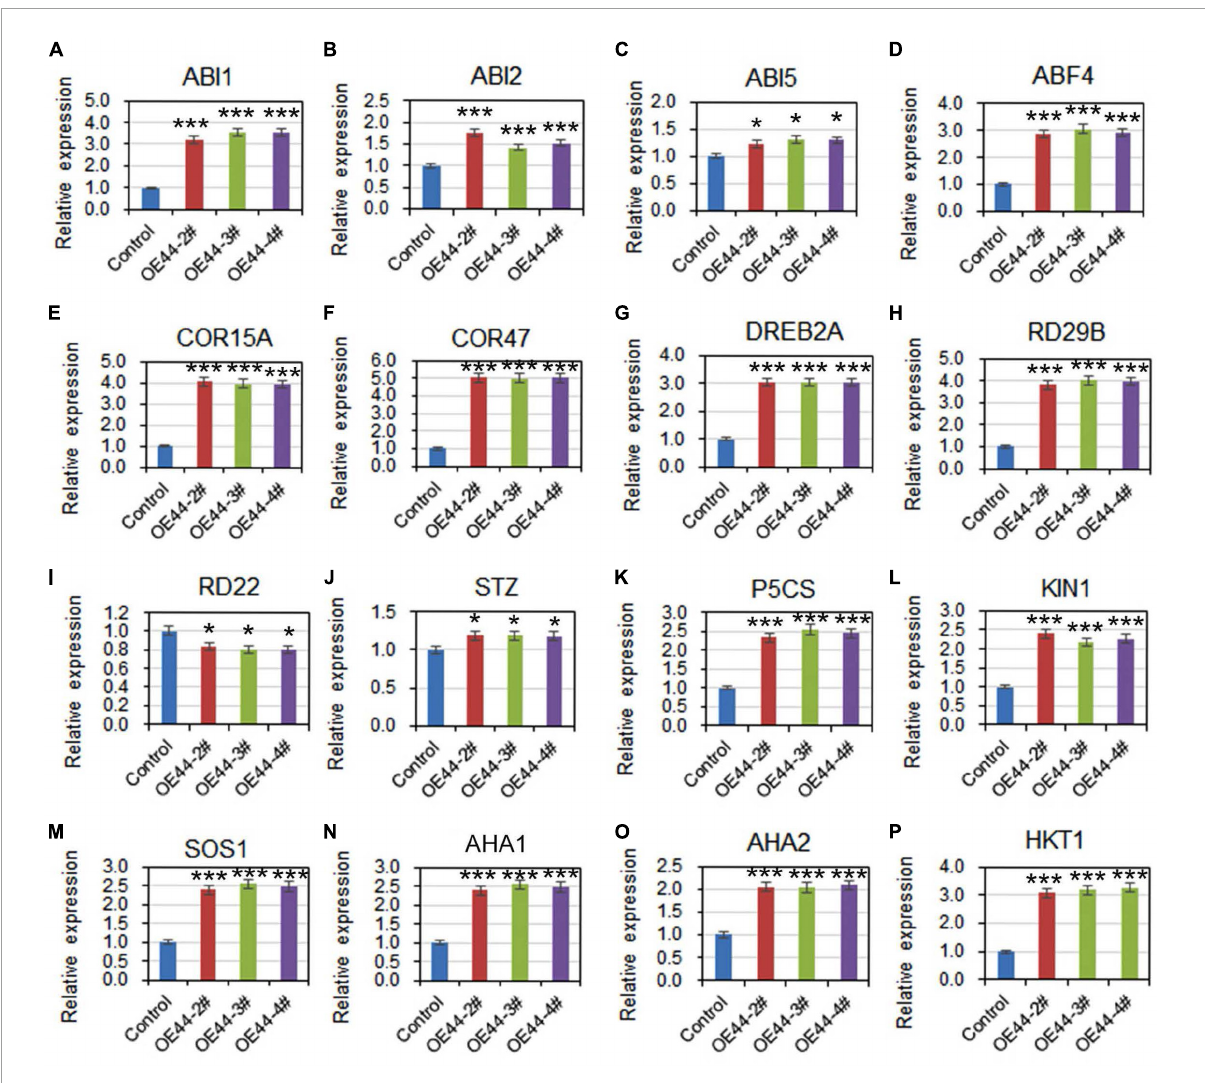
FIGURE8 HcWRKY44 regulated the expression of ABA- and stress-related regulators. (A–F) ABA-mediated genes including ABI1 , ABI2 , ABI5 , ABF4 , COR15A , and COR47 were selected to analyze their expression in HcWRKY44 transgenic lines and control lines under salinity stress for 7 days. (G–L) Stress-responsive genes DREB2A , KIN1 , RD29B , STZ , and P5CS were selected for evaluation of their expression level in the OE44-2#, OE44-3#, and OE44-4# lines and control lines. (M–P) Ionic homeotasis-related genes SOS1 , AHA1 , AHA2 , and HKT1 were selected for evaluation of their expression level in the HcWRKY44 transgenic lines and control lines. Each value was the mean ± SD of three independent replicates. * P < 0.05 and *** P < 0.01 represent significant differences between different samples by Student’s t